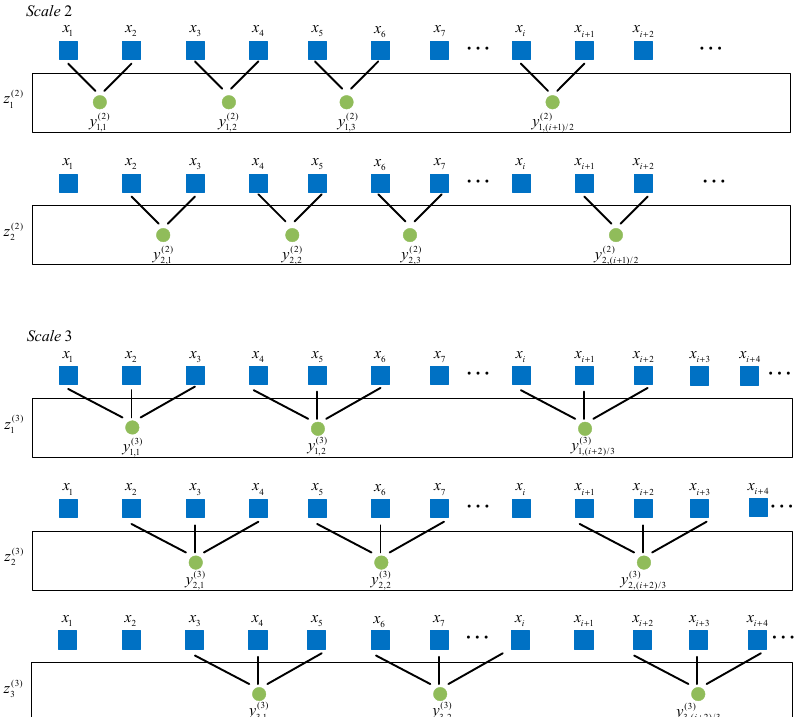
Figure 3. The improved coarse-graining procedures for scale factor τ =2 and τ =3.